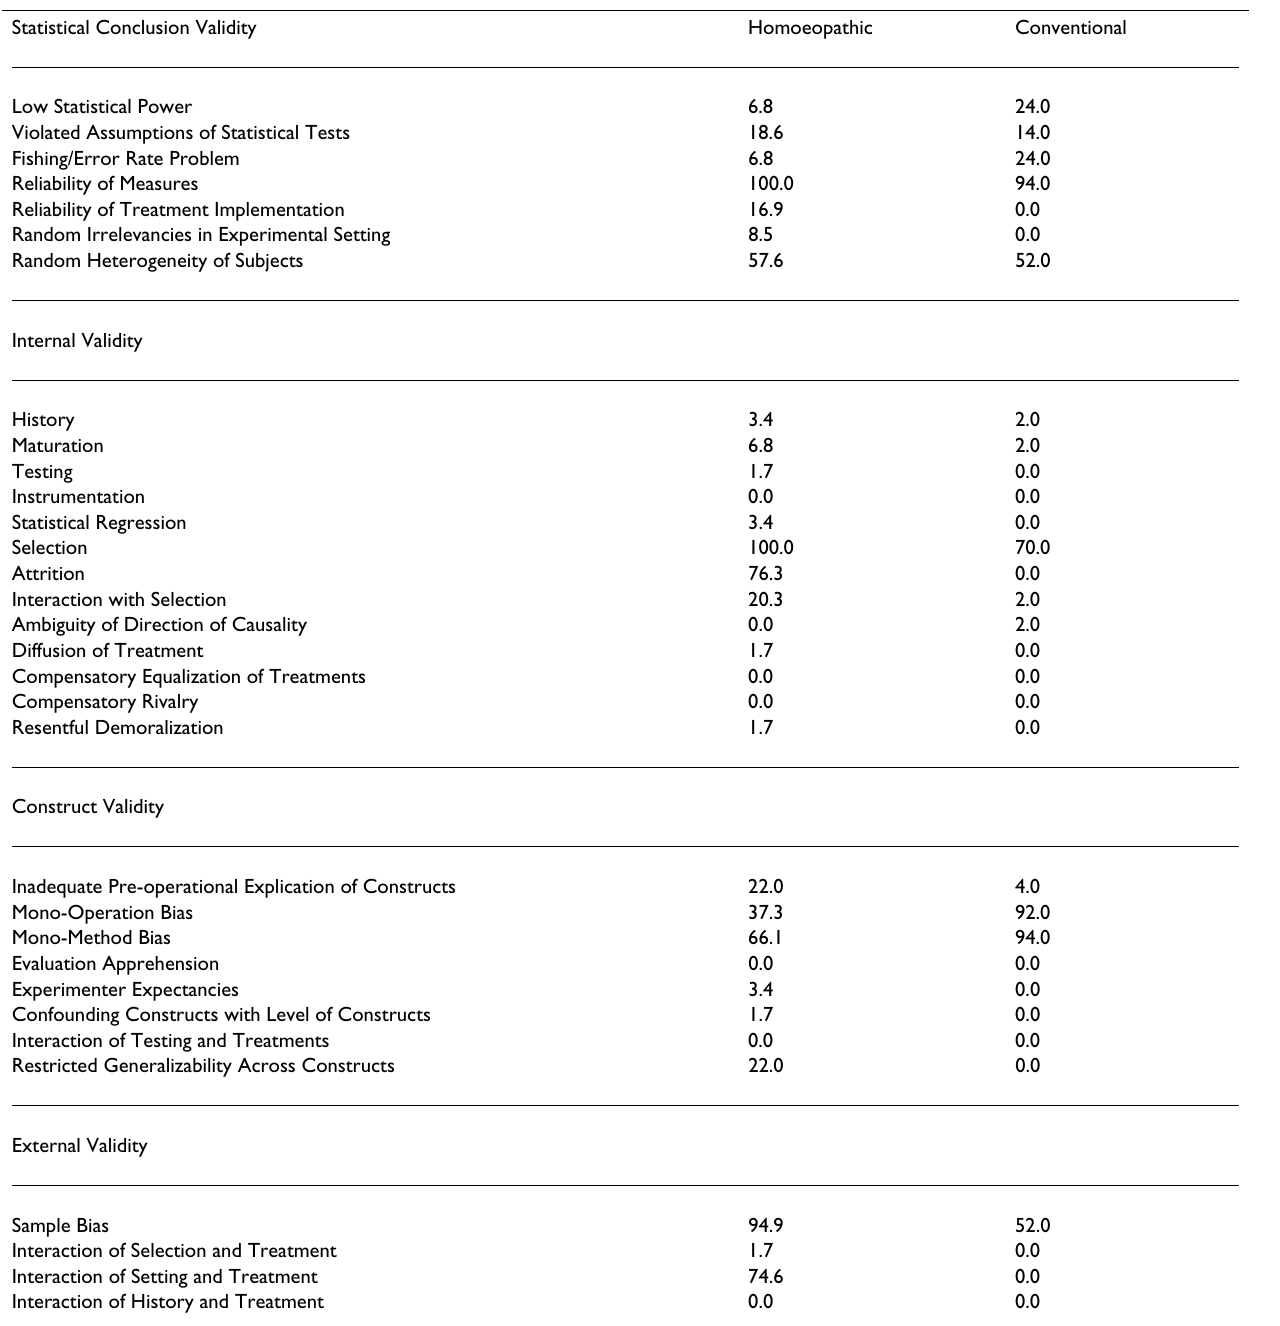
Table 3: Percent of studies with specific threats to validity of homeopathic and conventional